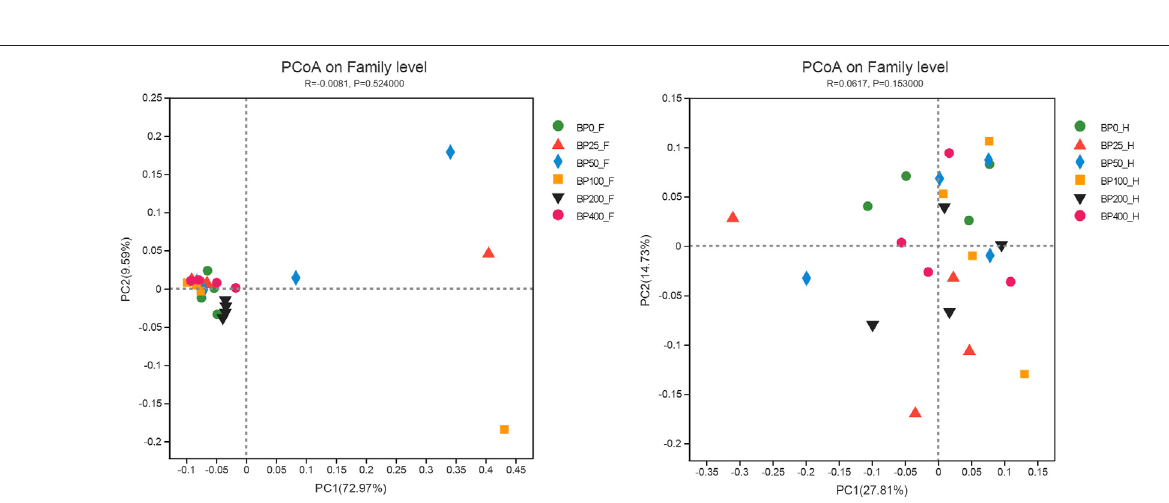
FIGURE 5 | PcoA analysis of intestinal microbiota on family